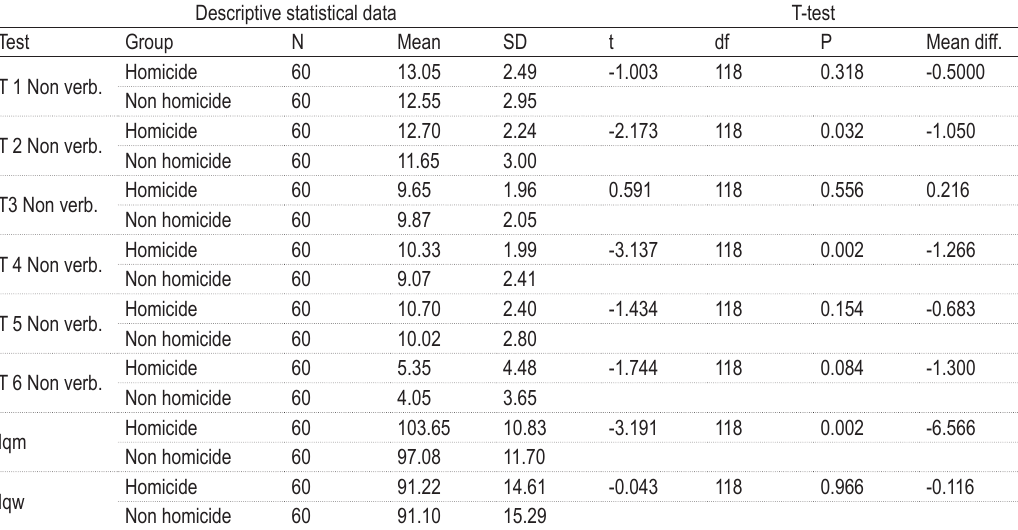
TABLE 1. Non-verbal tests (T 1 - T 6), verbal intelligence tests - descriptive statistics and intergroup differences test (T-test).